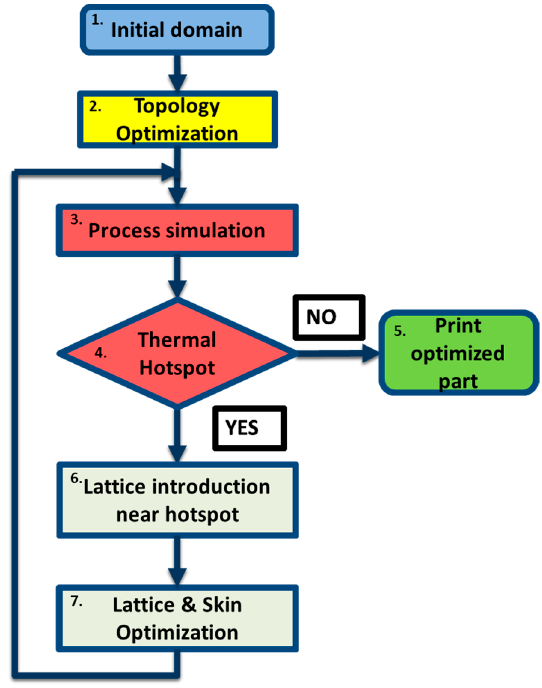
Figure 1. Proposed digital design approach for metal additive manufacturing to address thermal effects.